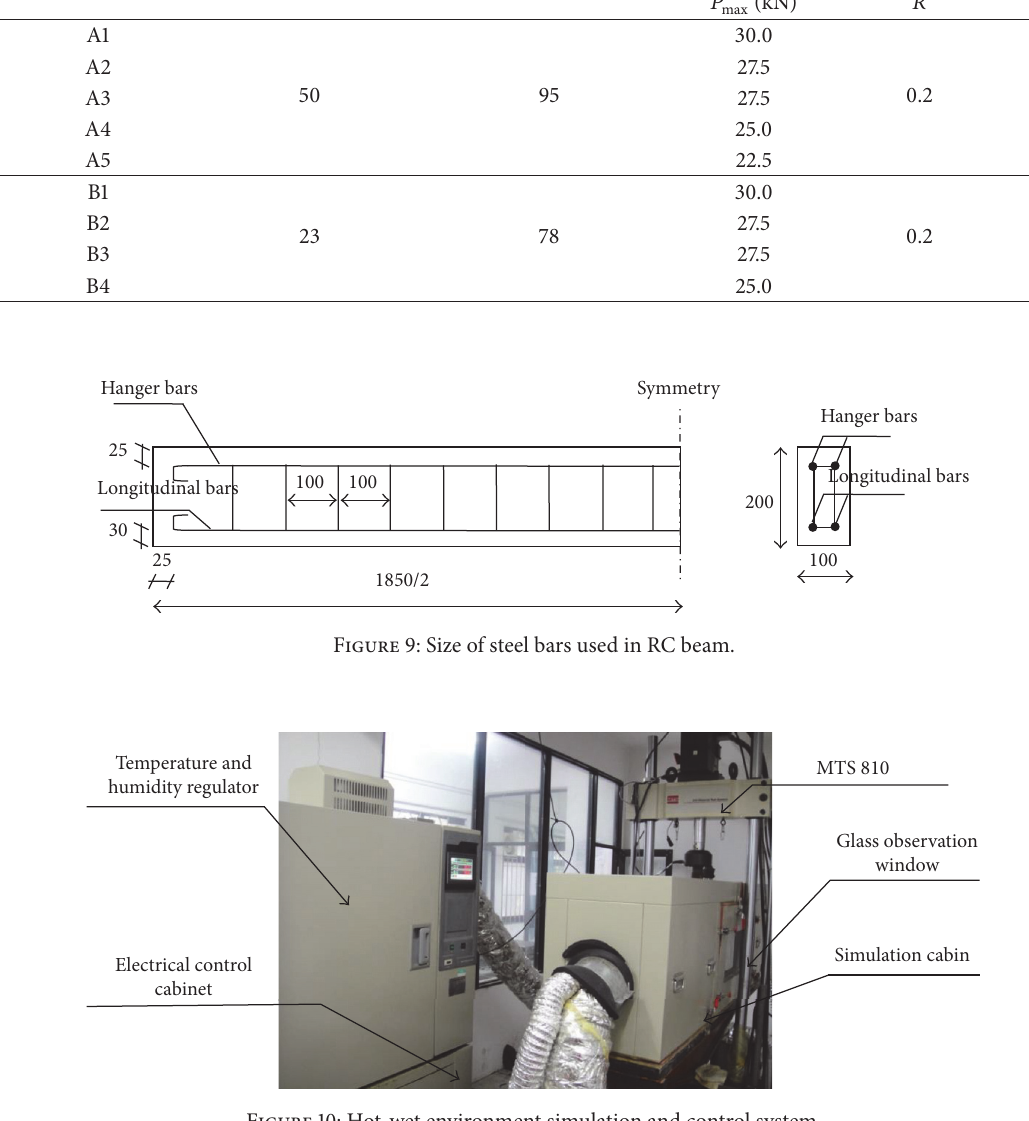
Figure 10: Hot-wet environment simulation and control